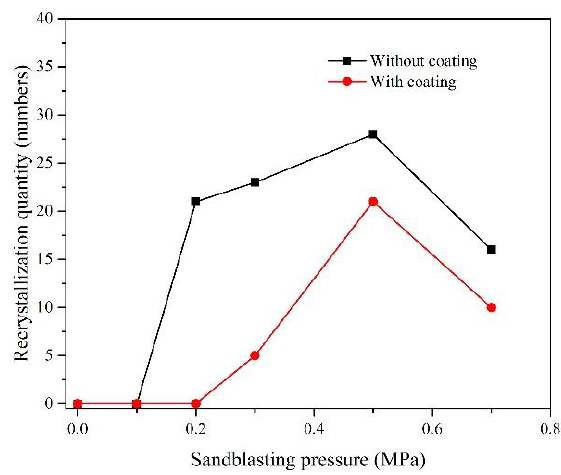
Figure 9. Relationship between the number of recrystallization cells and sandblasting pressure .